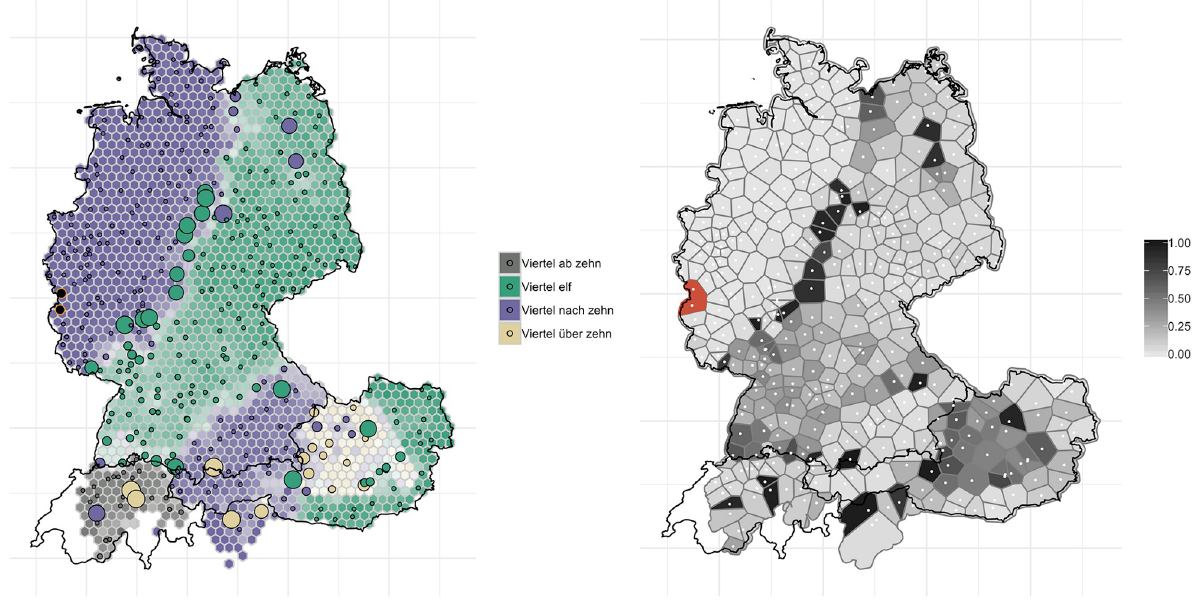
Fig 11. Variant and degree of change maps for ‘10:15’.